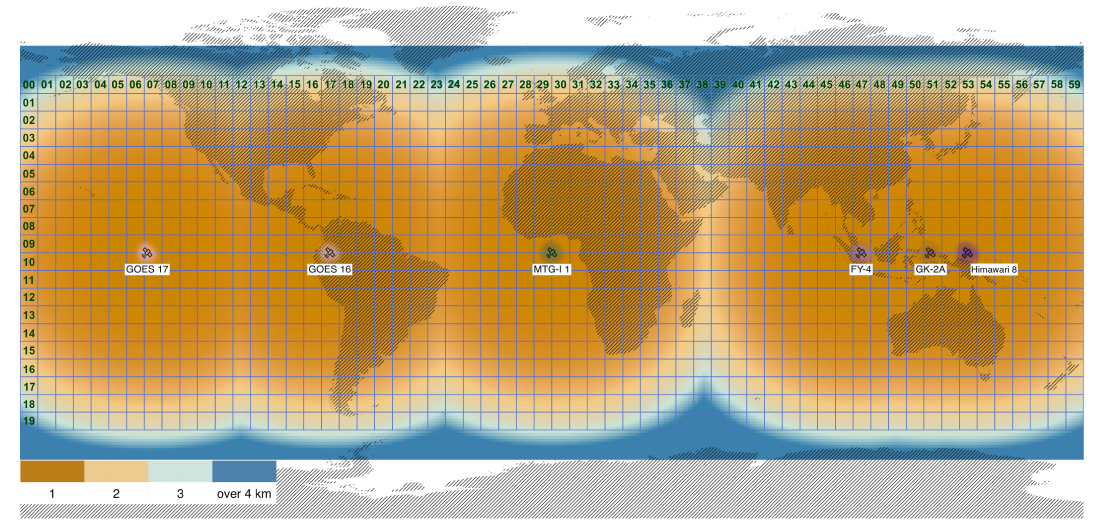
Figure 3. Global tiled grid of GeoNEX products in the geographic projection. The color scheme indicates changes in spatial resolution due to satellite viewing geometry, with the finest (nadir) resolution being 1 km. The third-generation geostationary satellites form a (quasi-)global constellation that effectively covers Earth’s surface from 60 ◦ N to 60 ◦ S. The thin blue lines indicate the 6 ◦ × 6 ◦ tiles, numbered horizontally from 0 to 59 and vertically from 0 to 19. MTG, MeteoSat Third